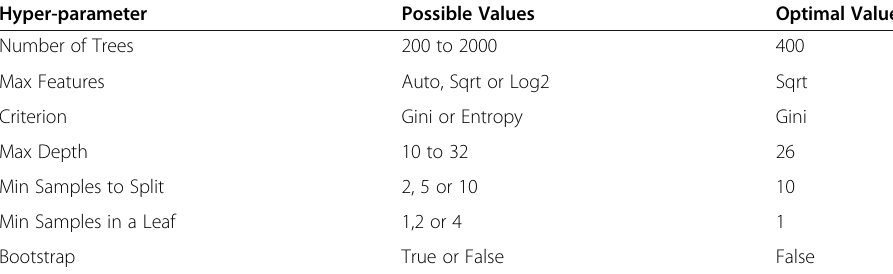
Table 1 Hyper-parameters possible and optimal values